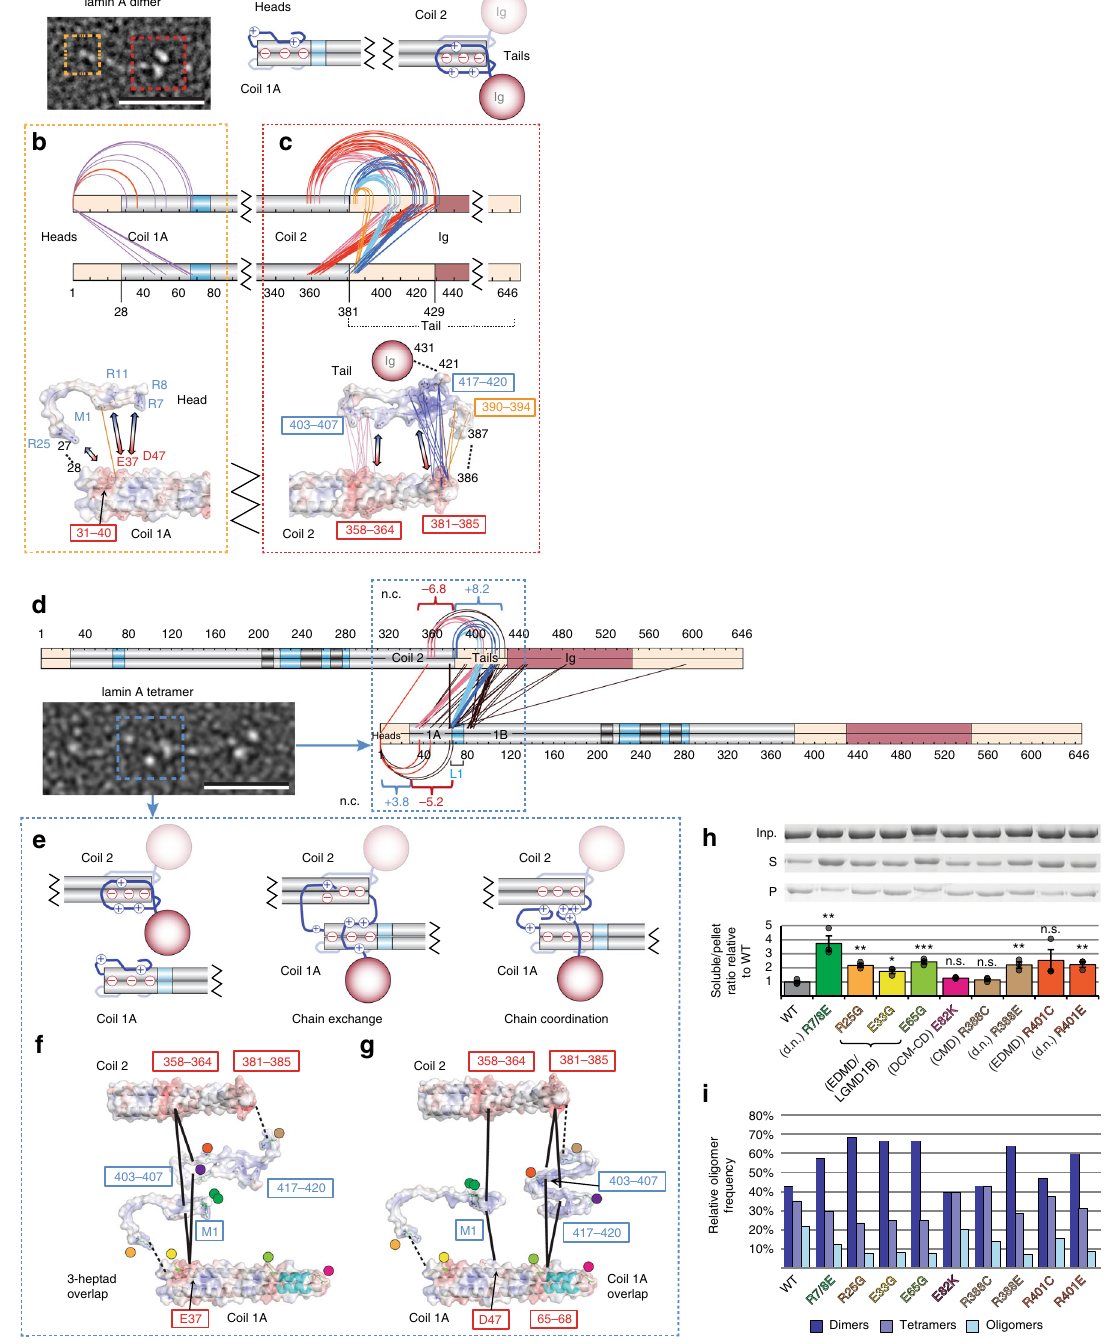
fl anking region arginines with disease-causing mutations or residues reversing charge (Fig. 8f, g coloured dots) increased solubility in conditions promoting lamin A polymerisation (Fig. 8h). Substituting glutamic acids with glycines in coil 1A achieved similar effects, while such substitutions further away in coil 1B had no effect. Direct examination of assembly stages by rotary metal shadowing EM on >1000 particles for each mutant revealed, compared to wild-type, an increase in free lamin A dimers relative to head-to-tail oligomers (Fig. 8i). Thus many disease mutations likely inhibit assembly by disrupting head-to-rod-to-tail